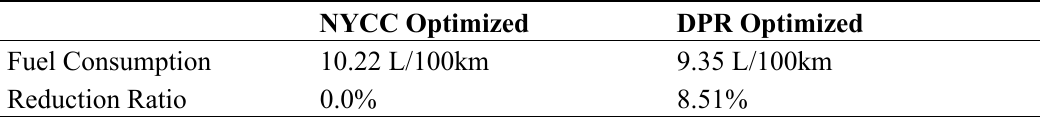
Table 5. Fuel consumption comparison of the DPR